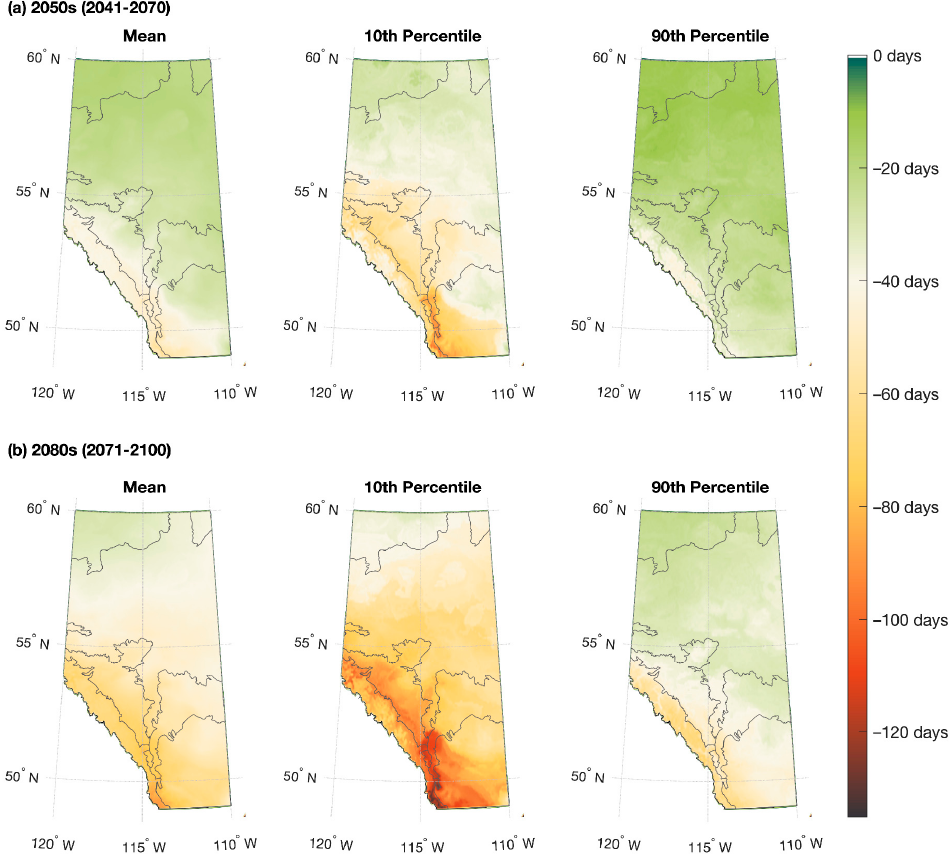
Figure 7. Projected change in winter duration—mean, 10th percentile (earliest), and 90th percentile (latest) between the historic period (1950–2017) and ( a ) 2050s (2041–2070) and ( b ) 2080s (2071–2100) for RCP 8.5.